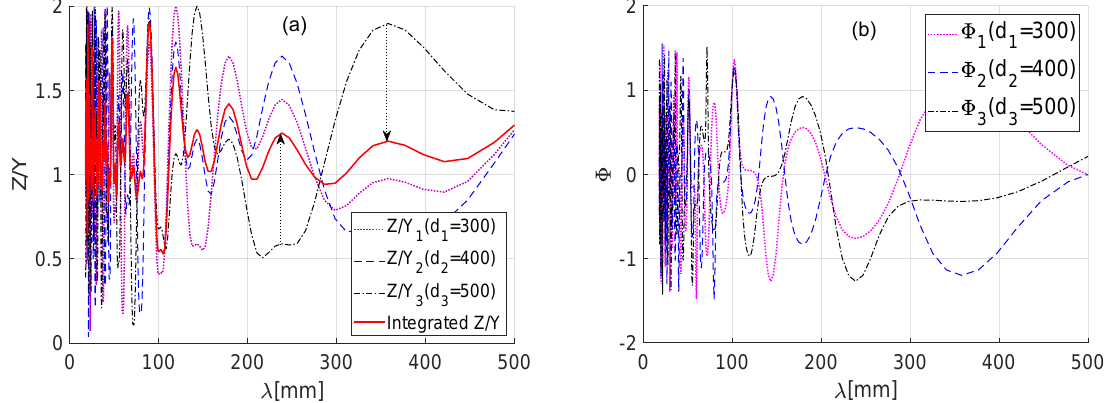
Figure 7. ( a ) Magnitude of the transfer function; ( b ) Phase angle of the transfer